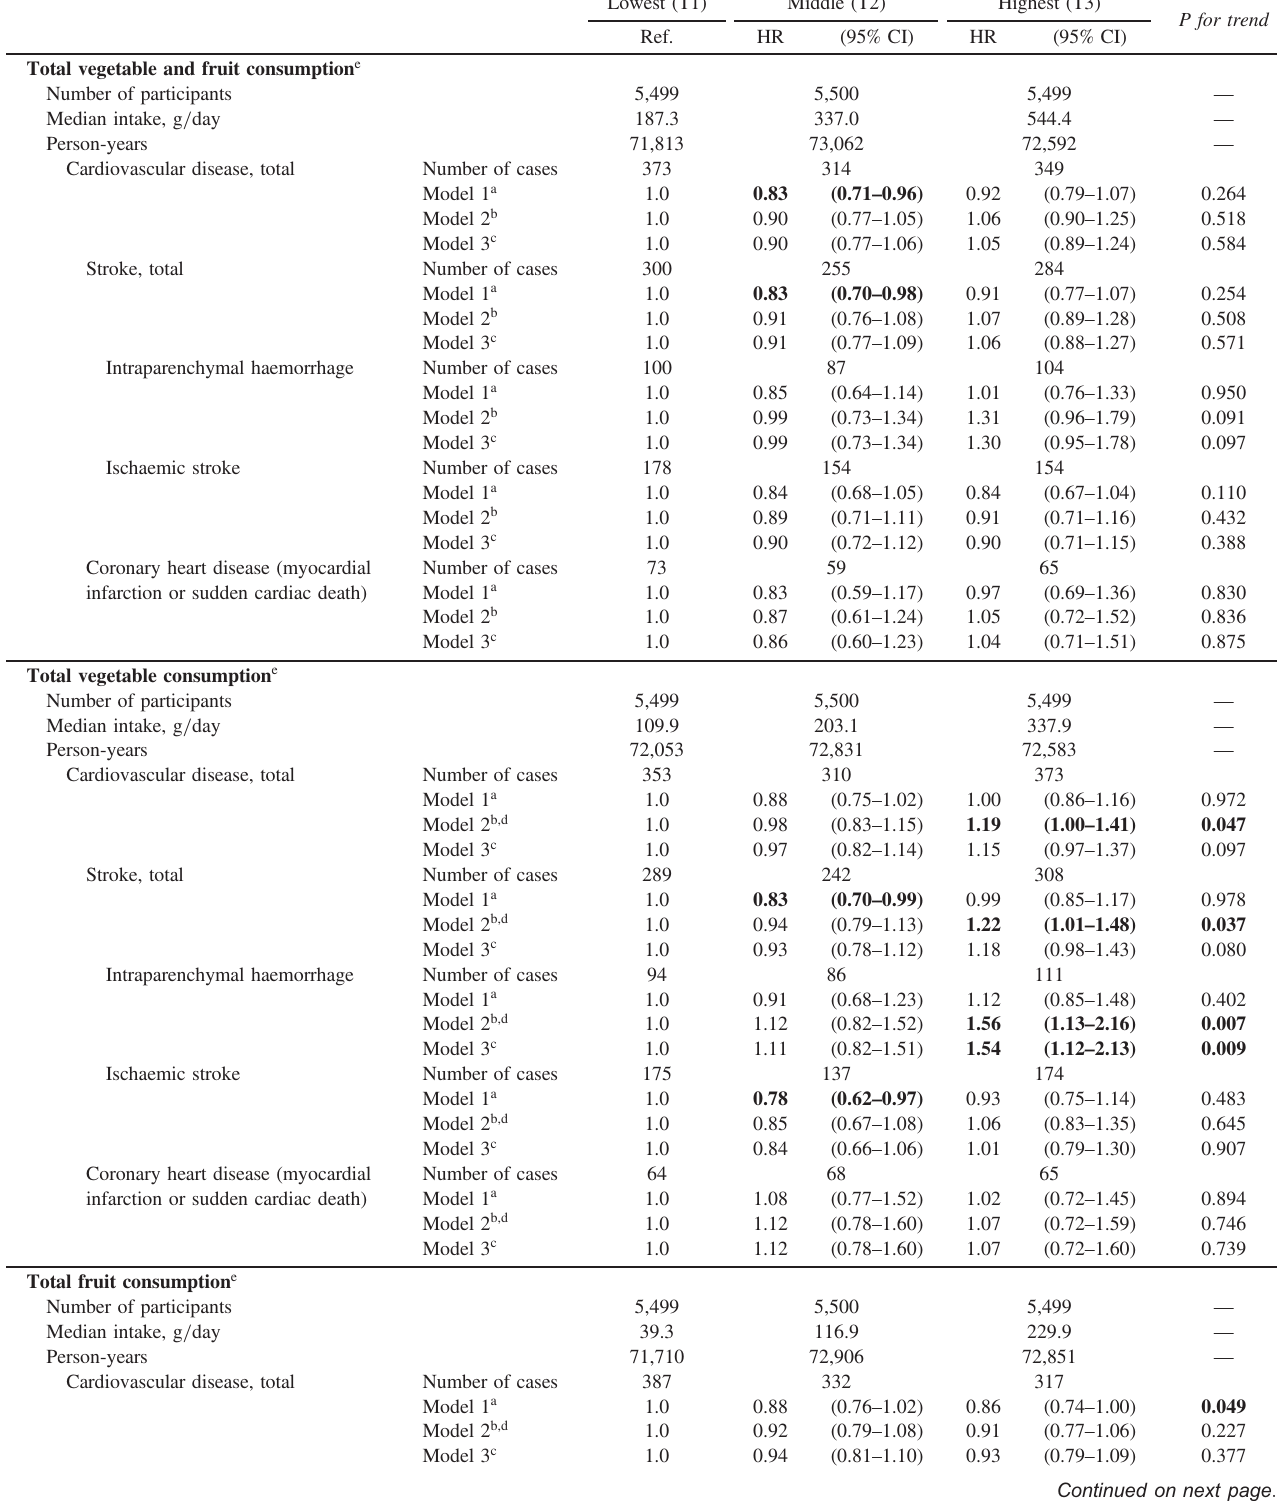
Table 2. Age-, sex-, and study area-adjusted and multivariate-adjusted hazard ratios and 95% con fi dence intervals of incident cardiovascular outcomes according to tertiles of consumption of total vegetables and fruits, total vegetables, and total fruits Lowest (T1) Middle (T2) Highest (T3) P for trend